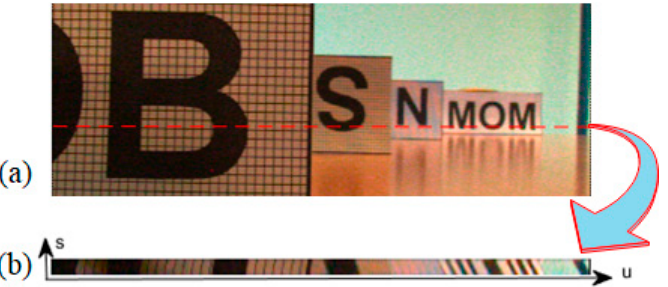
Figure 2. An example of an EPI. ( a ) is a central view image, ( b ) is an EPI corresponds to the row of the red dotted line in ( a ).